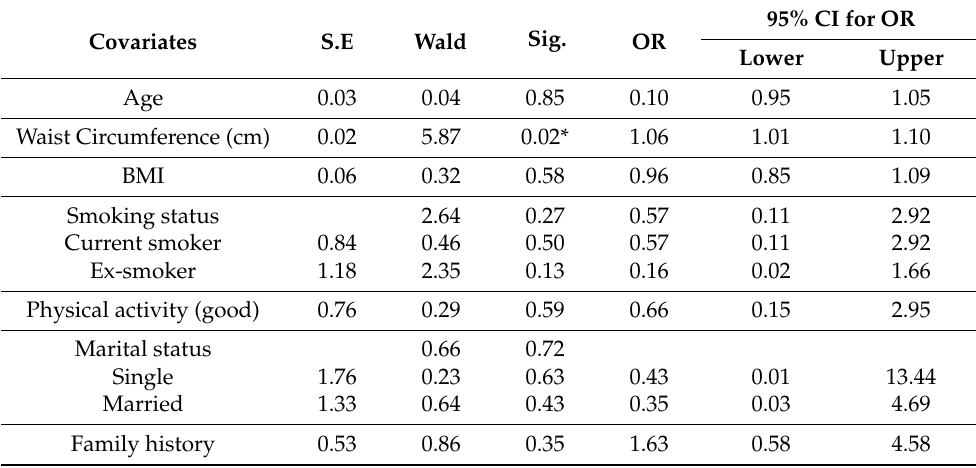
Table 10. Prediction of risk factors associated with plasma vitamin E